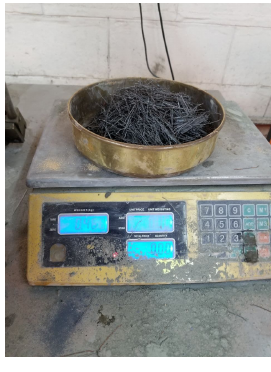
Figure 1: Steel fibre